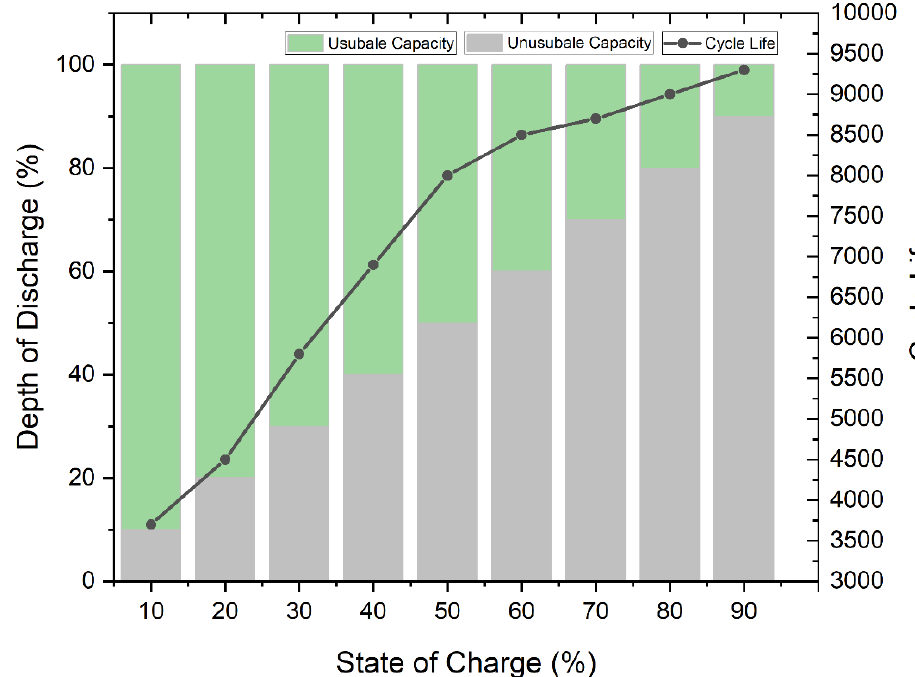
- Table 8. Specification of technology nickel batteries